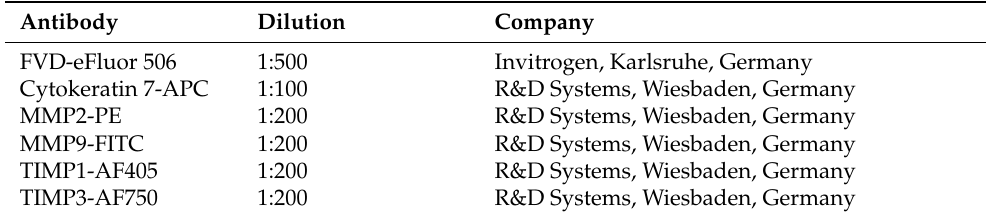
Table 1. Flow-cytometry